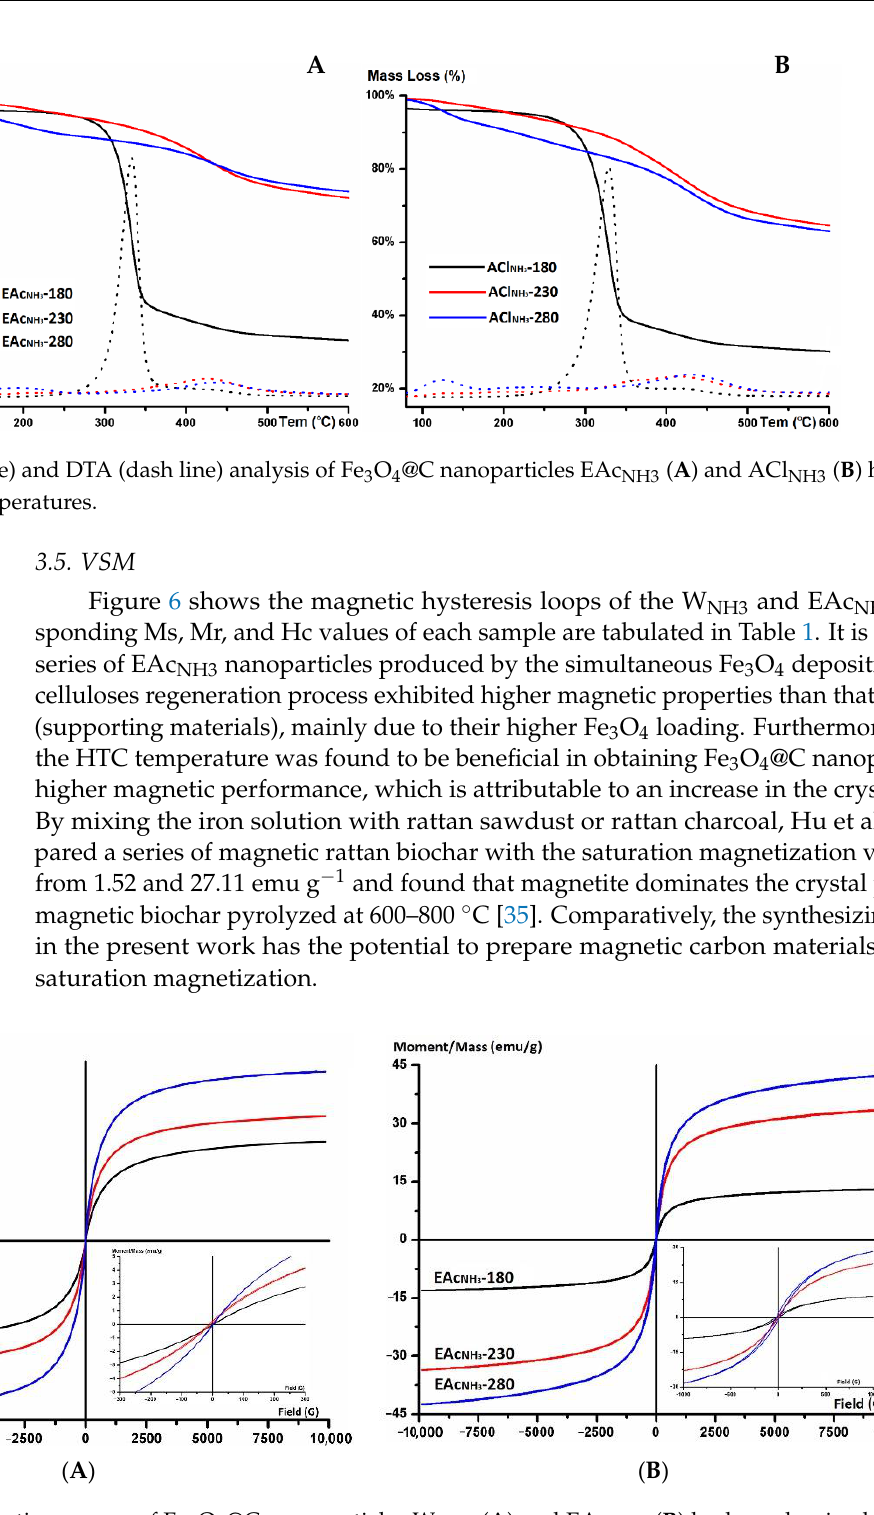
Figure 6. VSM magnification curves of Fe 3 O 4 @C nanoparticles W NH3 ( A ) and EAc NH3 ( B ) hydrocarbonized at different tem- peratures.